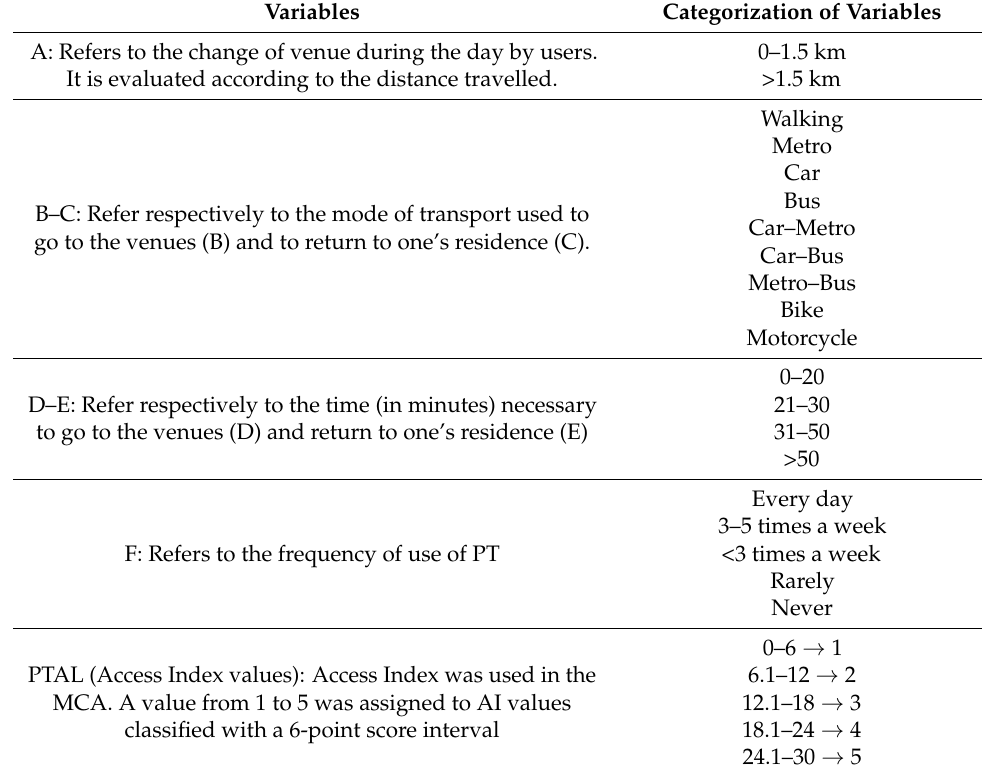
Table 2. Categorization of the variables used for the Multiple Correspondence Analysis (MCA) analysis. Variables